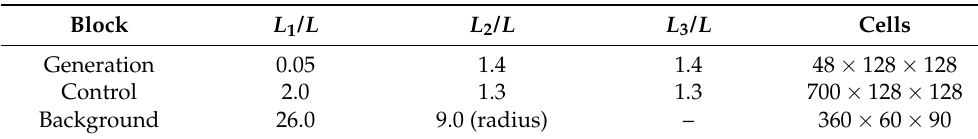
Table 1. Computational grid: main blocks size L i in the i -wise direction ( i = 1,2,3), and number of cells on the finest level.